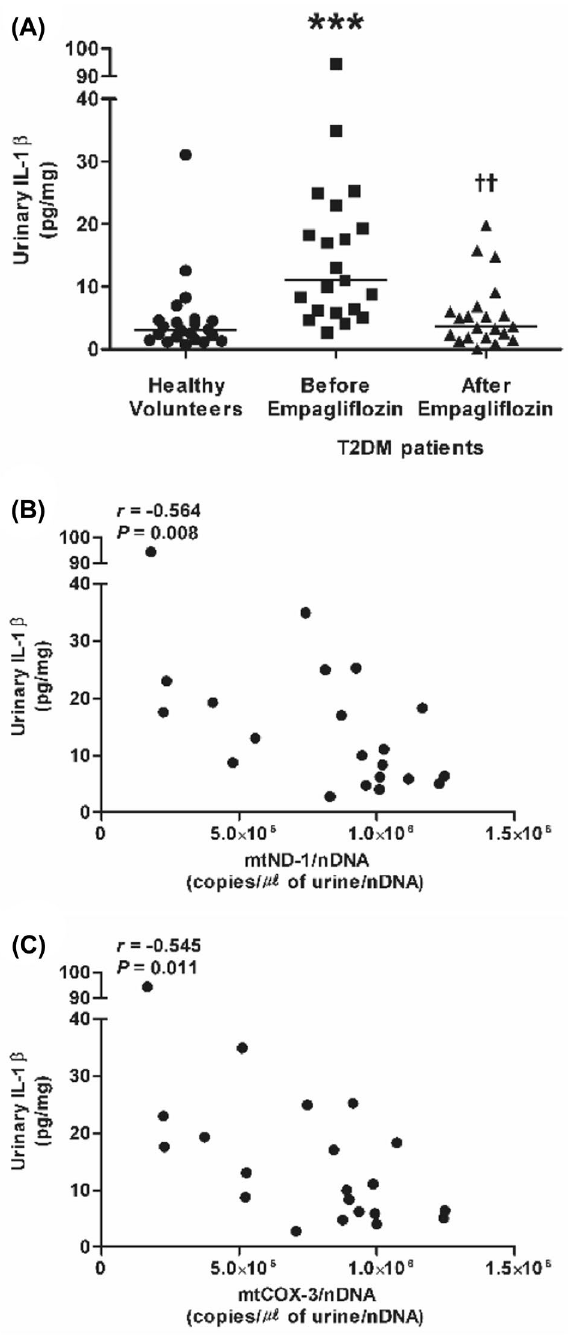
Figure 3. Urinary IL-1β in healthy volunteers ( n = 22) and T2DM patients ( n = 21) before and after empagliflozin treatment. ( A ) urinary IL-1β, ( B ) correlation with urinary mtND-1, and ( C ) urinary mtCOX- 3. Horizontal line represents median. *** P < 0.001 vs. healthy volunteers, †† P < 0.01 vs. before empagliflozin treatment. Statistical analysis was performed using SPSS (version 25.0, SPSS, Chicago, IL, USA, www. ibm. com/ analy tics/ spss- stati stics- softw are) and figure was plotted using GraphPad Prism (version 5.03, GraphPad Software, San Diego, CA, USA, www. graph pad. com). IL-1β interleukin-1β, mtCOX-3 cytochrome-c oxidase 3, mtND-1 nicotinamide adenine dinucleotide dehydrogenase subunit-1, nDNA nuclear DNA, T2DM type 2 diabetes